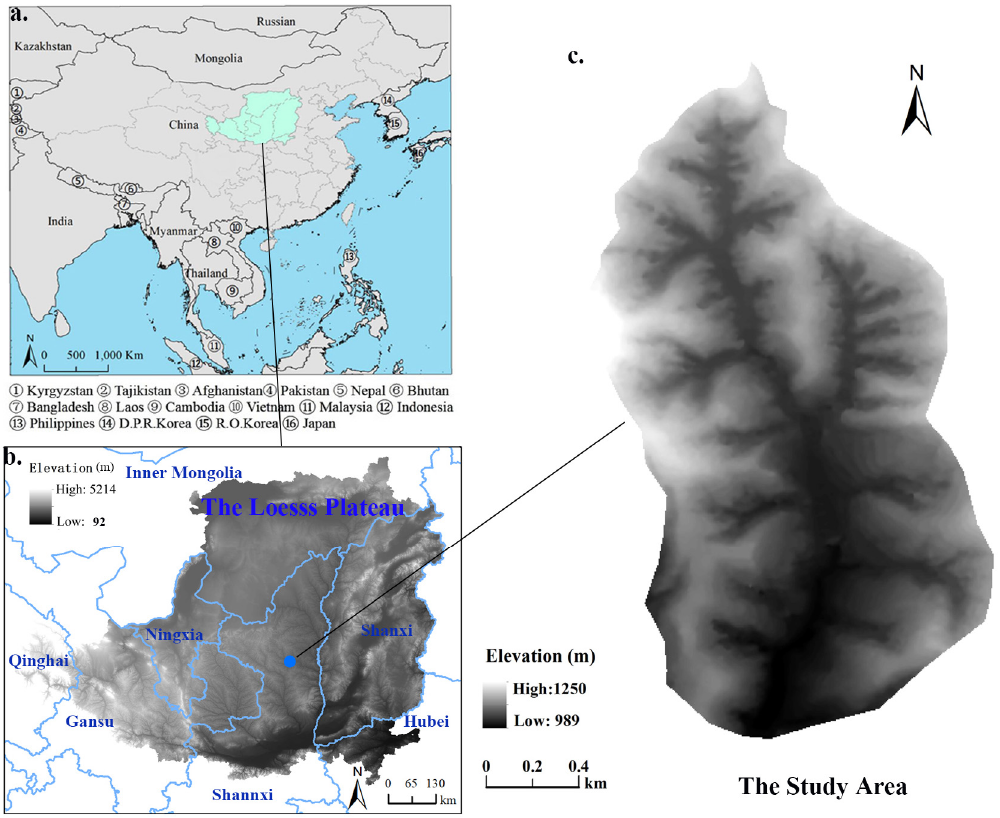
Figure 1. The geographical location and DEM of the study area. ( a ) Location of the Loess Plateau; ( b ) location of the study Figure 1 . The geographical location and DEM of the study area. (a) Location of the Loess Plateau; (b) location of the study area; (c) boundary and altitude of the study area. area; ( c ) boundary and altitude of the study